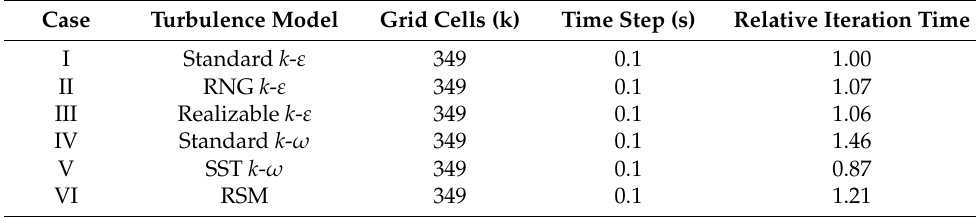
Table 5. Computational expenses of the six turbulence